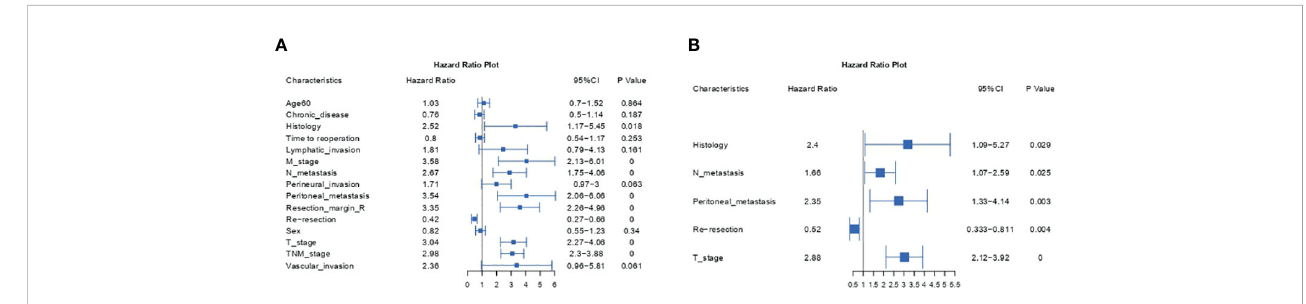
FIGURE 1 Forest plots of the univariate (A) and multivariate (B) Cox